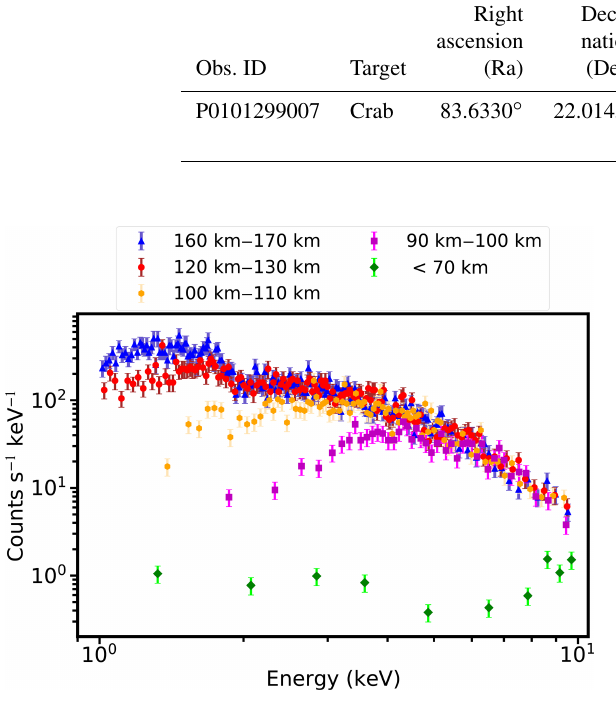
Figure 4. Illustration of an X-ray Earth occultation of the Crab Neb- ula, showing the light curve discussed in Sect. 2.2, the four contact points t I , t II , t III , and t IV , and the quantities t o , t F , t T , t c , and δ defined in Sect. 2.3. As a low-earth orbit (LEO) satellite, Insight- HXMT can observe the Crab Nebula twice in one orbit (egress and ingress). The length of t F is half the orbital period minus the dura- tion of two occultations, and the orbital period of Insight-HXMT is about